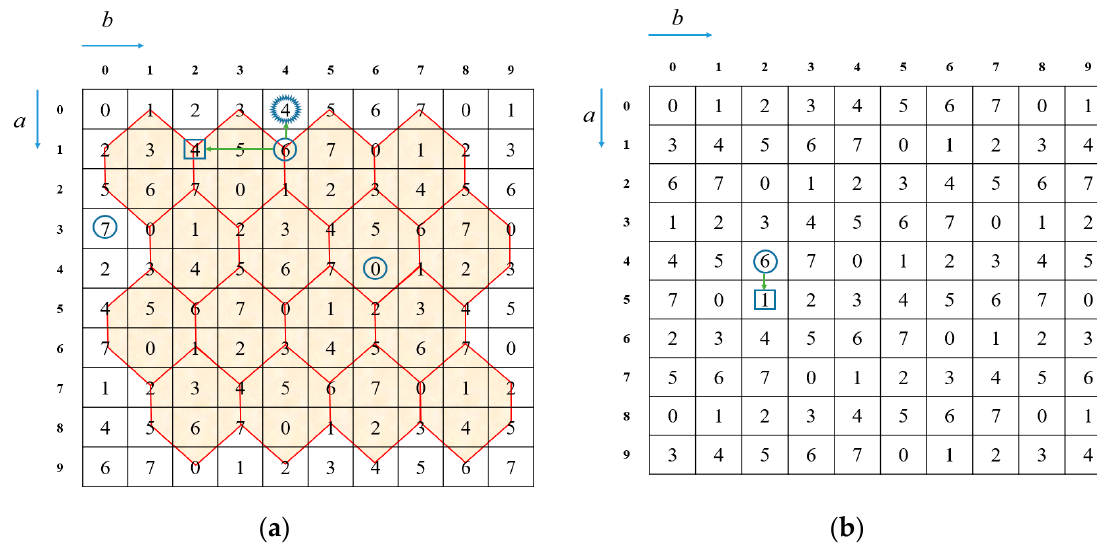
R ; ( b ) Partial reference table Figure 1. Embedment of TSE and PPM. ( a ) Partial reference table of R TSE ; ( b ) Partial reference table of R PPM . 3 3 3